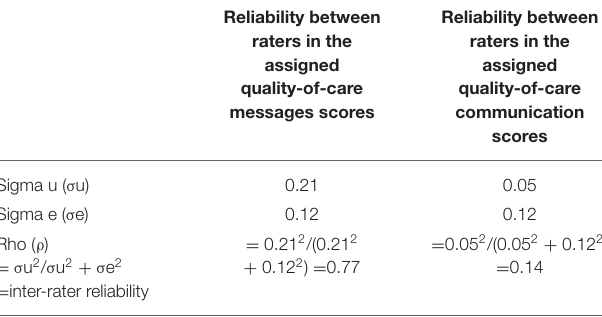
TABLE 5 | Estimated inter-rater reliability in multilevel modeling analysis.